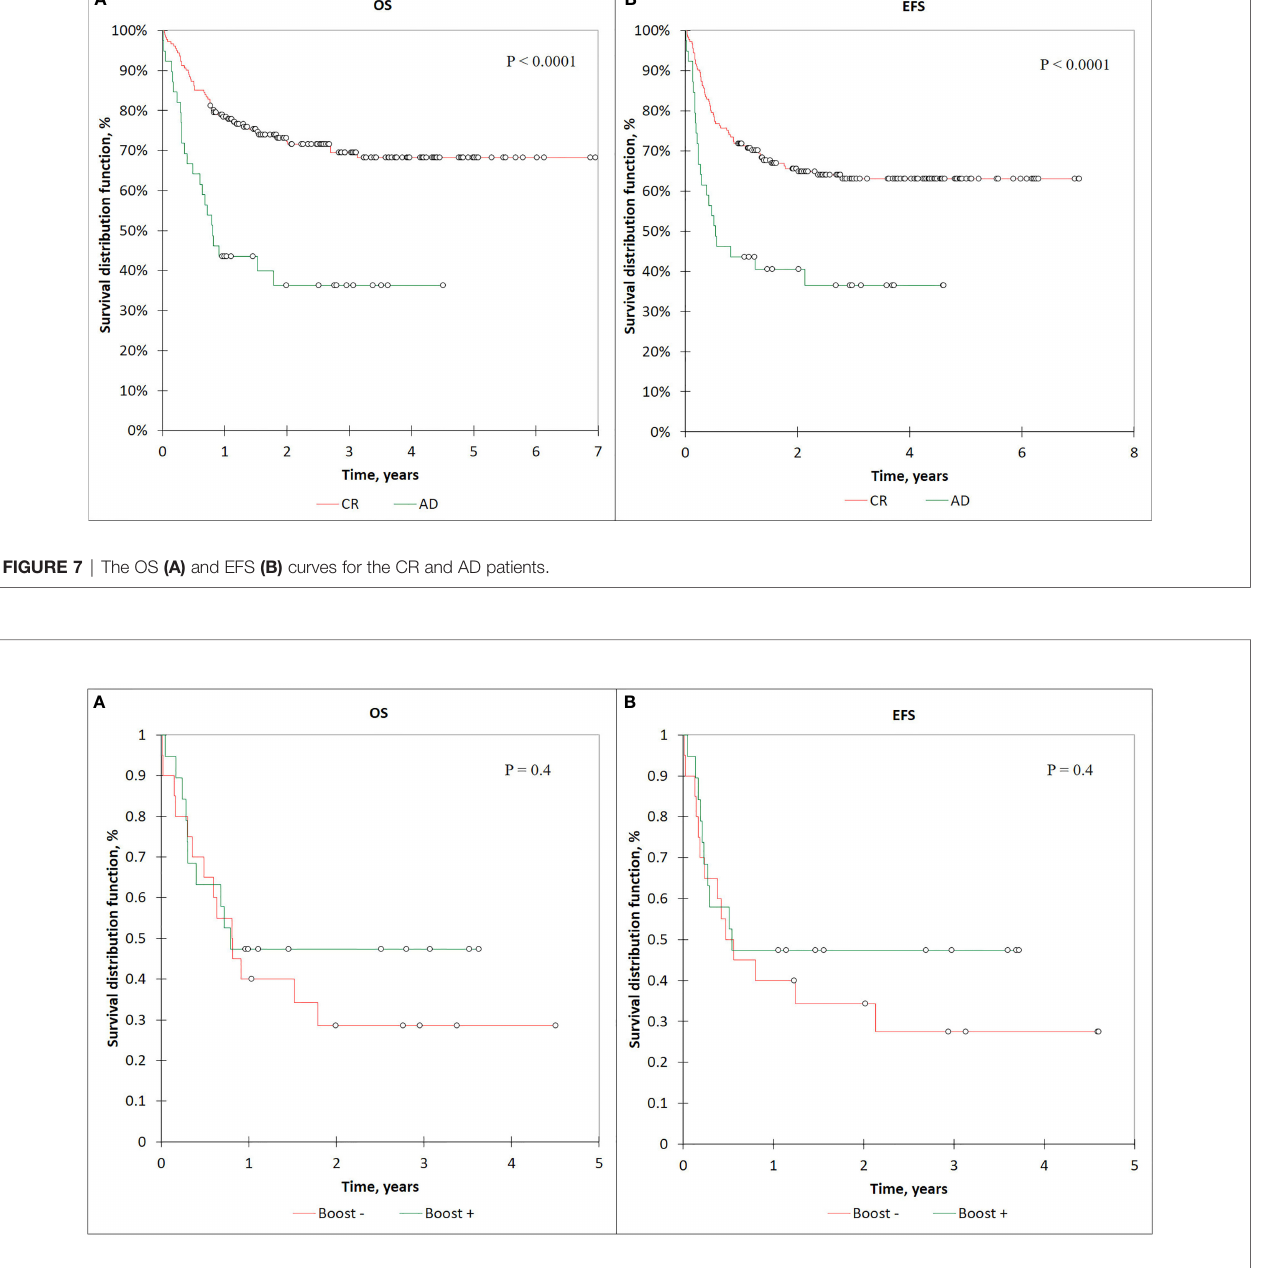
FIGURE 8 | OS (A) and EFS (B) curves for AD patients who received SIB to BM.